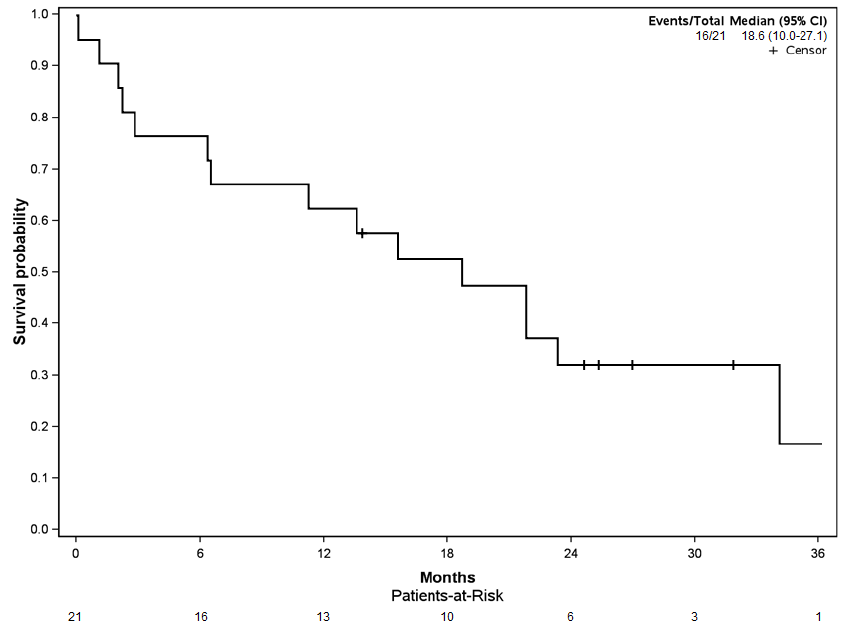
Figure 5. Kaplan – Meier curve for patient overall survival. Figure 5. Kaplan–Meier curve for patient overall